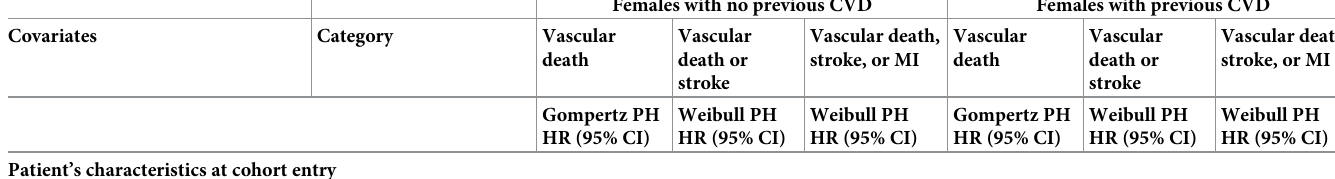
Table 1. Risk equations for CVD endpoints in the CKD–CVD policy model